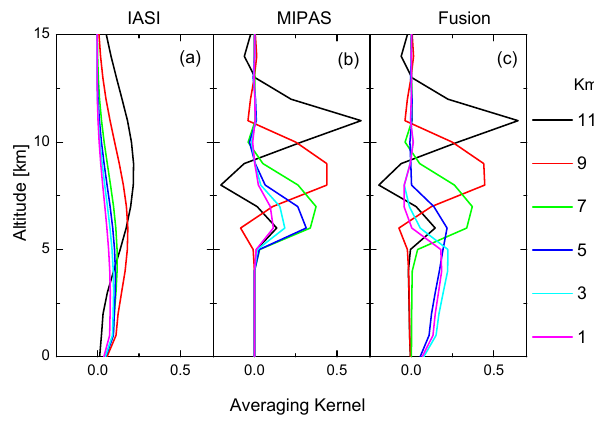
Fig. 5. AKs for the simulated case relative to 1, 3, 5, 7, 9, 11km altitudes, in the altitude range 0–15km, for the profiles retrieved us- ing only the IASI measurement (a) , only the MIPAS measurement (b) and the IASI-MIPAS data fusion (c) .